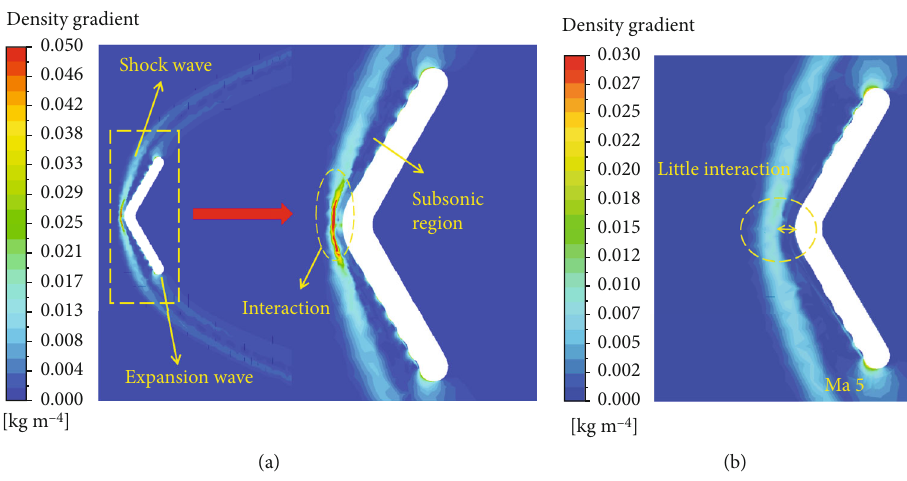
Figure 10: Interaction of shock wave and boundary layer: (a) Ma 12; (b) Ma